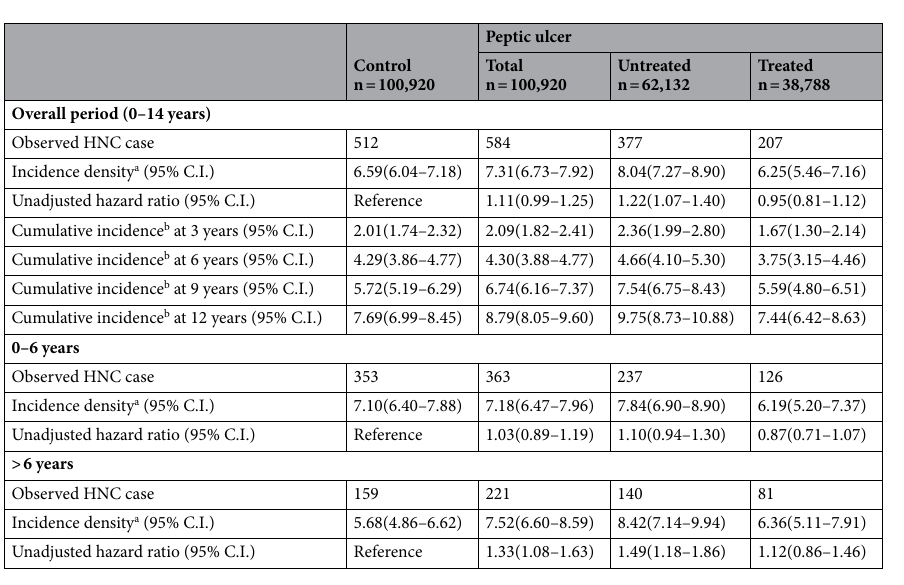
Table 1. Incidence per 10,000 person-years and crude relative risk for head and neck cancer during 14 years follow-up period. PSM = propensity score matched; HNC = head and neck cancer. a Incidence density rate, per 10,000 person-years. b Cumulative incidence probability, per 1000